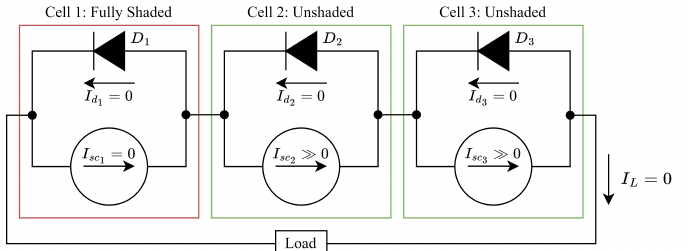
Figure 1. Current inconsistency encountered with the simplest photovoltaic (PV) cell model during instances of differing solar irradiance. Developed from [18].